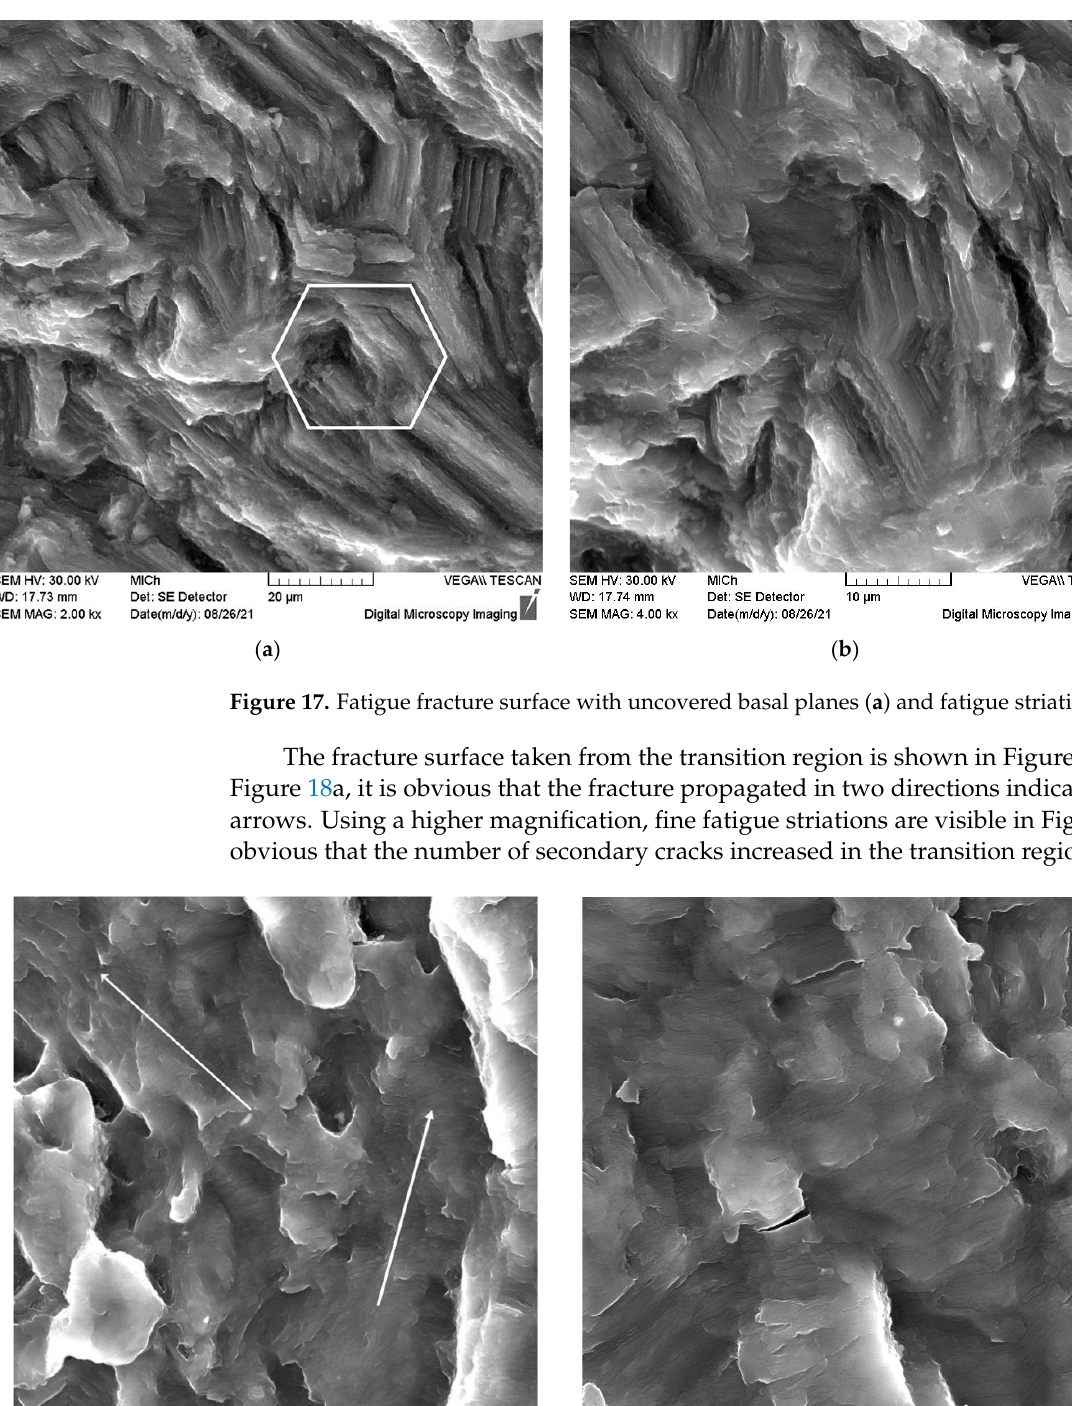
Figure 16. Deformed grains on the surface of the fracture and traces of the basal planes ( a ), river morphology, and secondary cracks on the surface of the fracture ( b ).